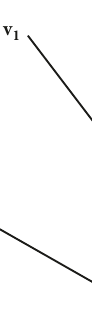
Figure 4: Communication graph with five